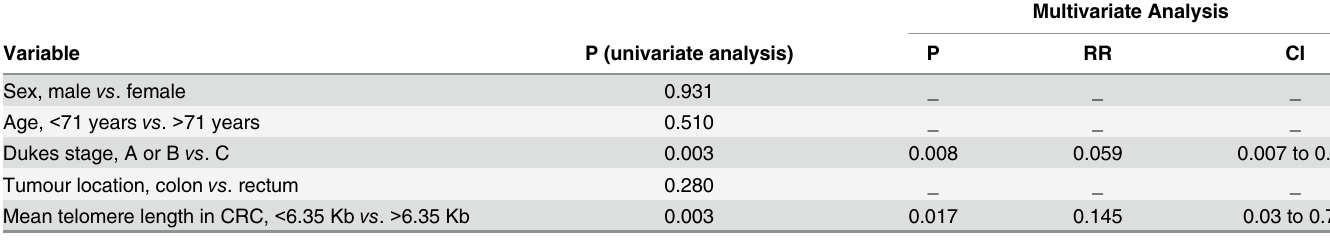
Multivariate Analysis